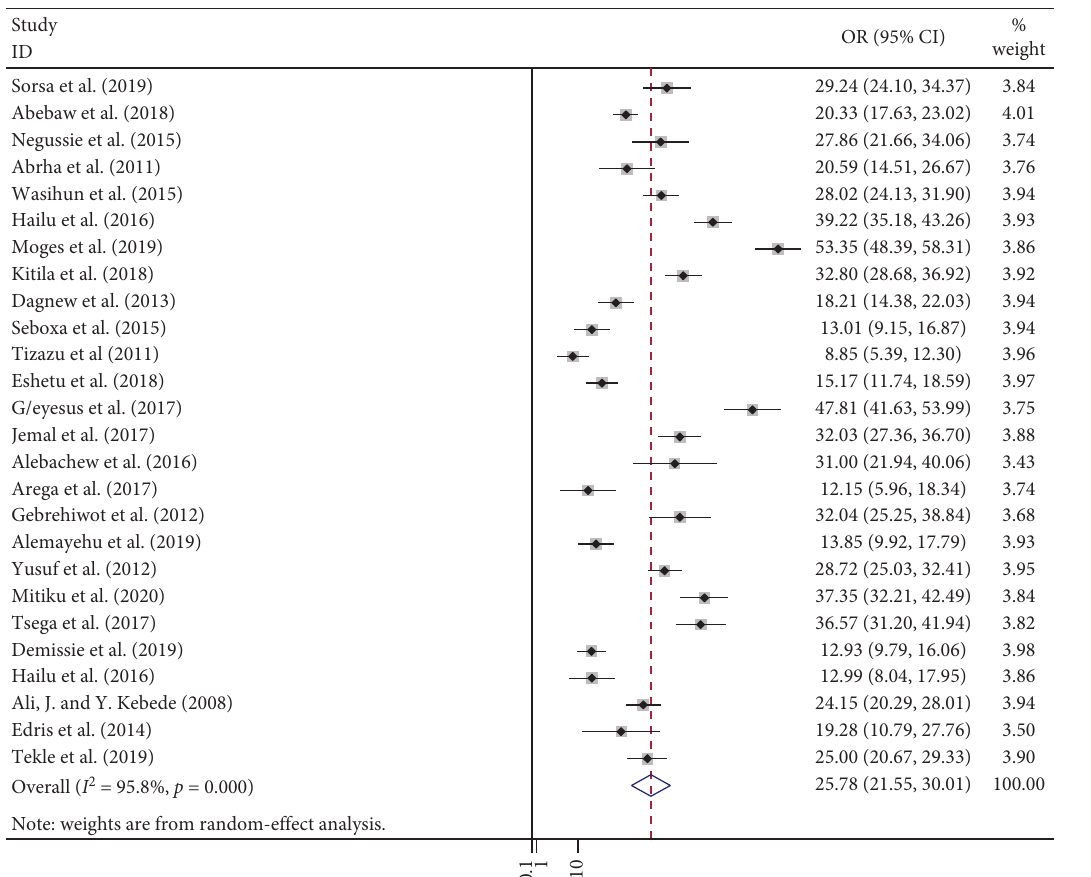
Figure 2: Forest plot showing the pooled prevalence of bacterial profile among patients with suspected bloodstream infections in